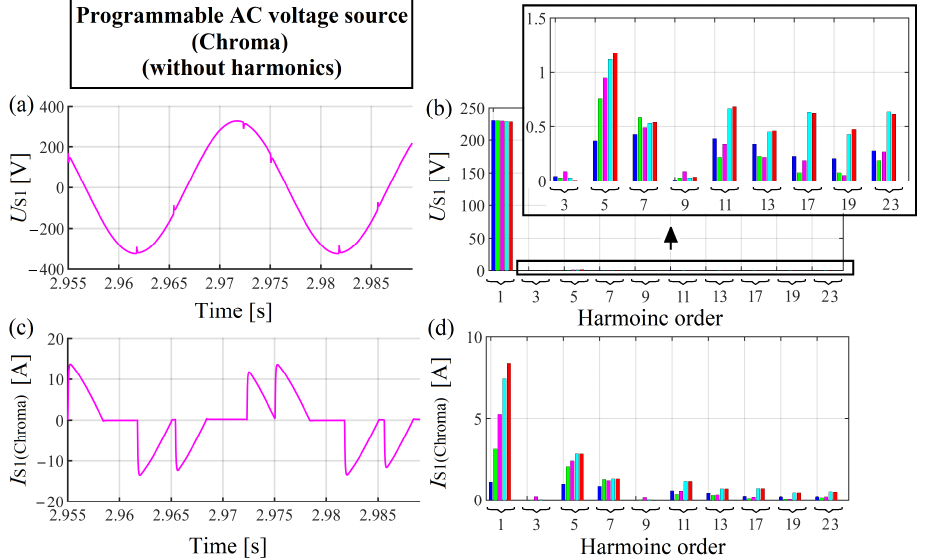
Figure 24. Waveforms and spectrums when the filter is not connected: ( a ) PCC voltage waveform with ( b ) its spectrum, ( c ) voltage source input current with ( d ) its spectrum (only the load is con- nected).